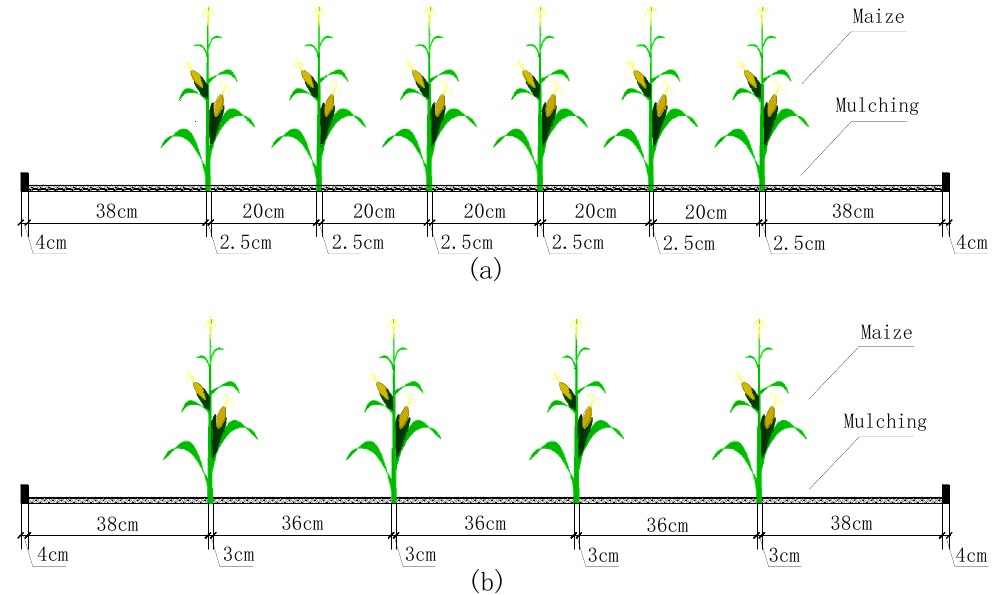
Figure 2. Sketch of experimental site. ( a ) represents the front view; ( b ) represents the lateral view.